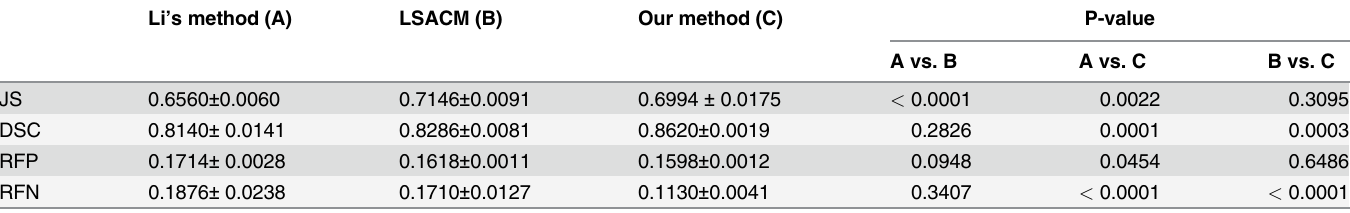
Table 3. Summary of Welchs t test analysis results of performance evaluations of WM segmentation quality between different methods (for 120 simulated MR image slices of the normal brain). Li ’ s method (A)